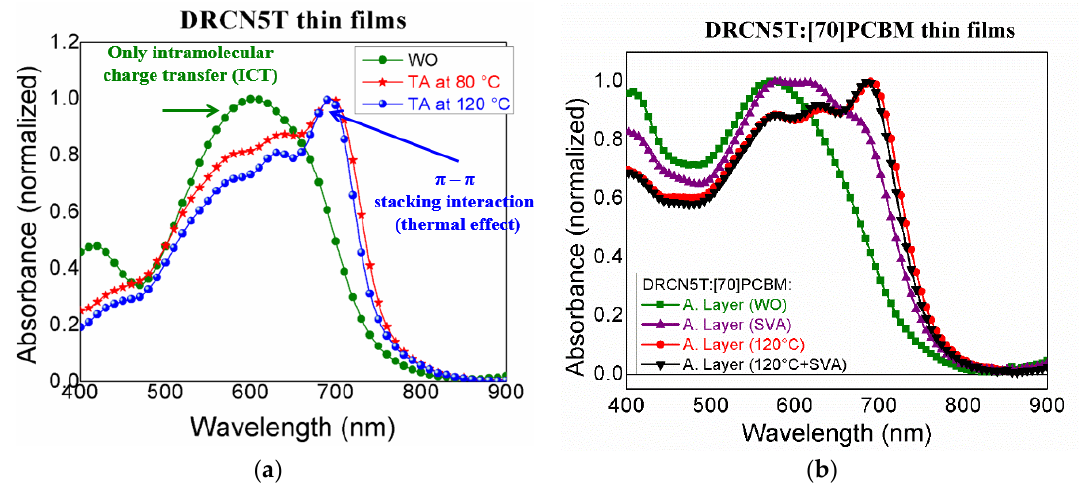
Figure 6. Absorption spectra of ( a ) DRCN5T thin films, and ( b ) DRCN5T:[70]PCBM thin films under different TA (and SVA for the case of the blend) treatments.